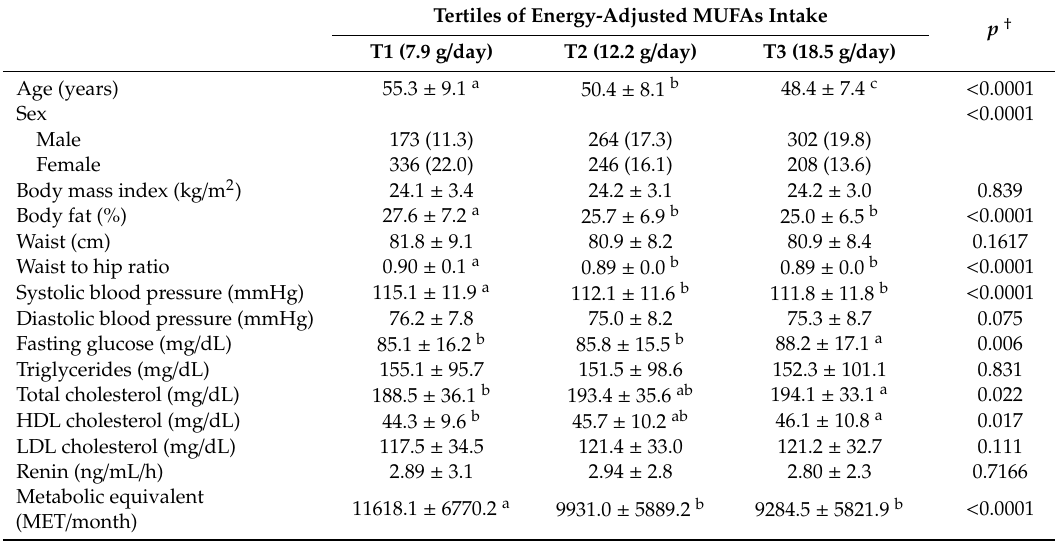
Table 1. Baseline characteristics according to energy-adjusted * dietary MUFAs intake among KoGES study participants ( n = 1529).